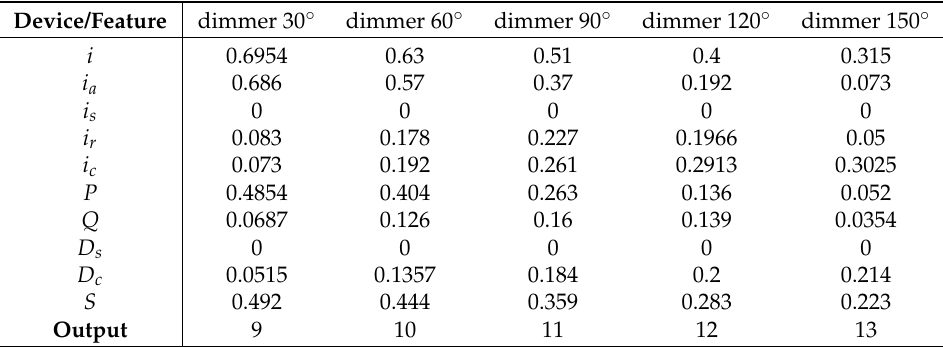
Table 3. CPC features for the dimmer various operation states (different excitation angles).